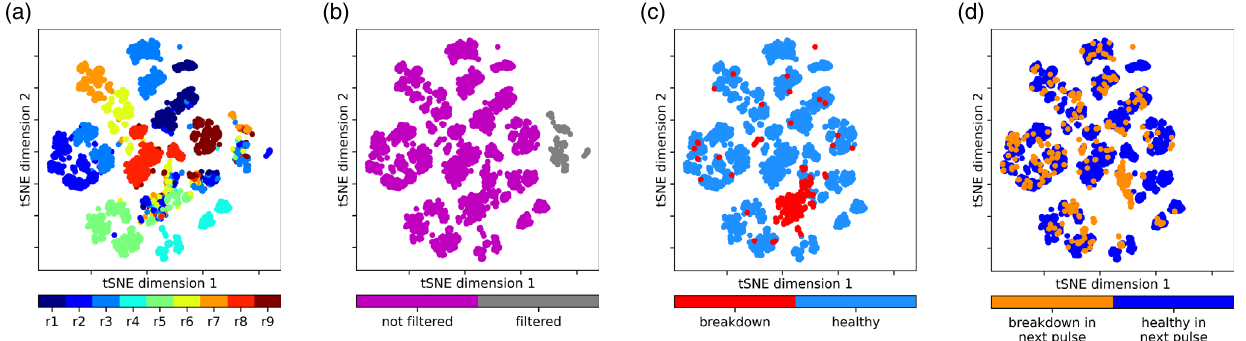
FIG. 8. 2D-tSNE of XBOX2 trend data during stable operation. The algorithm is able to distinguish between (a) stable runs, (b) not filtered and filtered events, and (c) breakdown and healthy events. In (d), no clear separation of events with a breakdown in the next pulse and a healthy event in the next pulse is possible. All representations in (c) are a subset of not filtered events in (b) and all representations in (d) are a subset of all healthy signals in